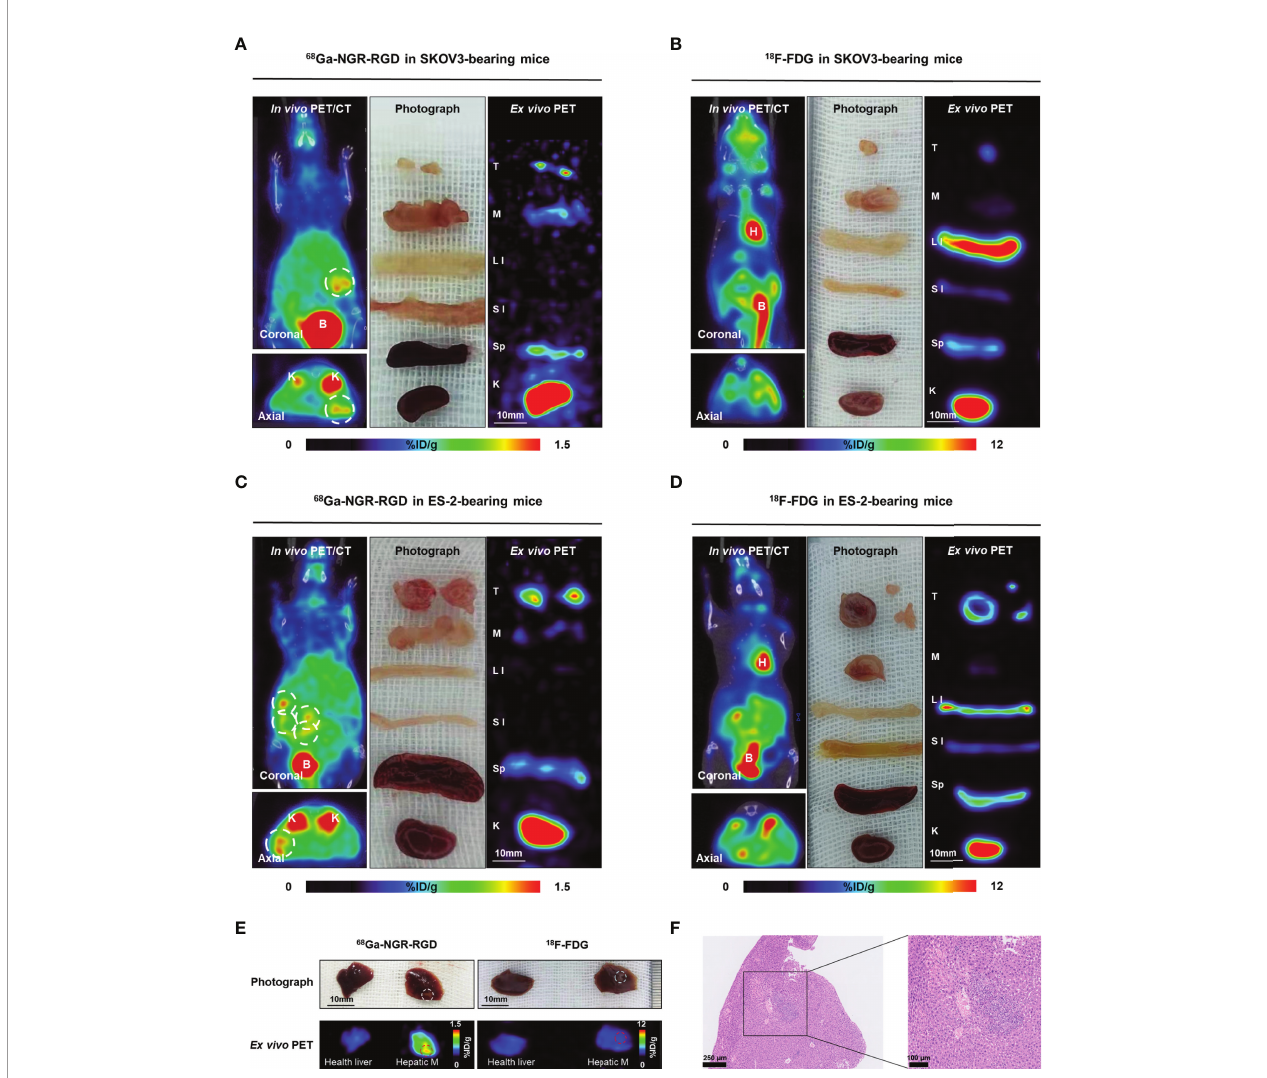
FIGURE 4 | Radiological-surgical correlation of abdominal metastatic models. (A – D) Representative static PET/CT images of 68 Ga-NGR-RGD and 18 F-FDG in SKOV3 and ES-2 abdominal ovarian metastasis models at 1 h post injection. In 68 Ga-NGR-RGD PET/CT imaging, several metastatic lesions with strong uptake were found in the peritoneal space [ (A, C) , white circle]. In 18 F-FDG PET/CT imaging, there were several stripe high uptake foci (B, D) . Surgical exploration was done in the same animal after PET/CT imaging. Diffuse reddish-white nodules with a slightly fi rm texture were seen in the peritoneal space. Ex vivo PET imaging of excised tissues was performed. The small metastases showed relatively high 68 Ga-NGR-RGD uptake and low 18 F-FDG uptake. H, heart; B, bladder; T, tumor; M, muscle; LI, large intestine; SI, small intestine; Sp, spleen; K, kidney. Scale bar = 10 mm (E) ES-2 hepatic metastases (Hepatic M) showed strong uptake of 68 Ga-NGR-RGD, but a similar low uptake of 18 F-FDG as healthy liver. (F) HE staining con fi rmed that the lesion on liver was tumor tissue. Scale bar = 250 m m or 100 m